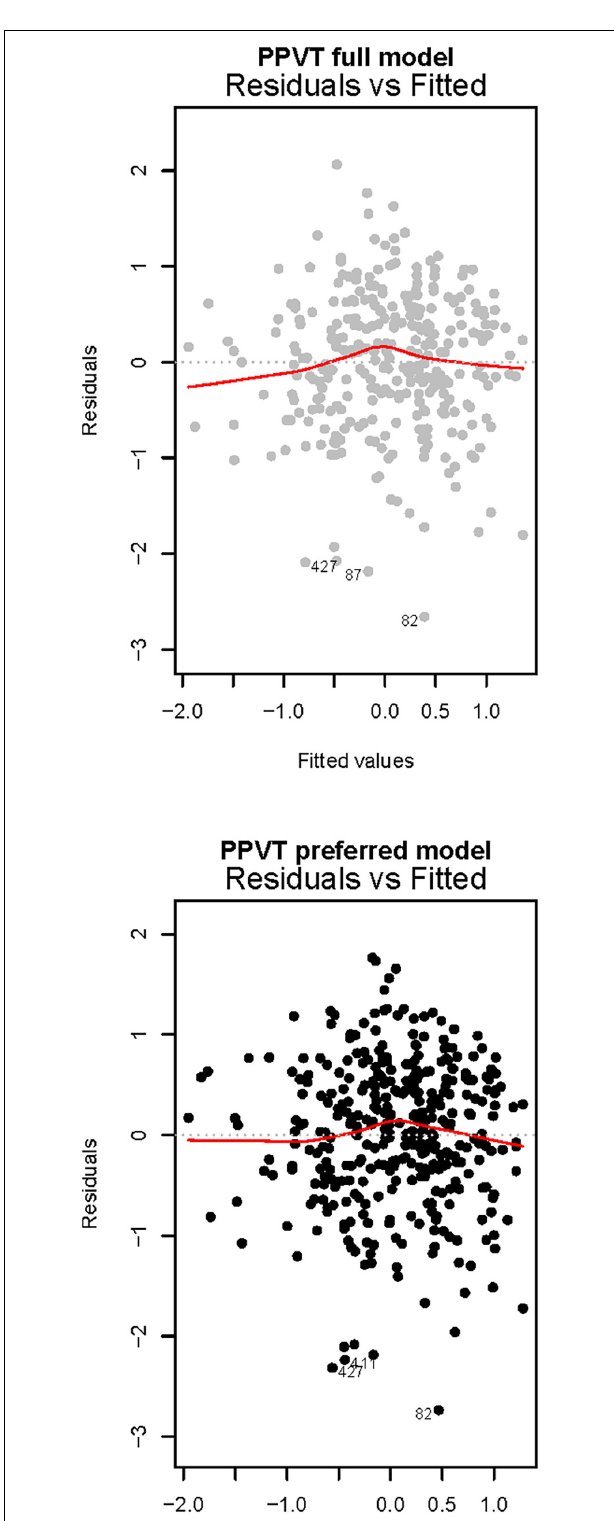
FIGURE 3 | Residuals versus fitted plots of receptive vocabulary regression models. The full model for receptive vocabulary included all predictors and explained 41% of PPVT score variance, whereas the preferred model included only significant predictors, explaining 40% of PPVT variance.